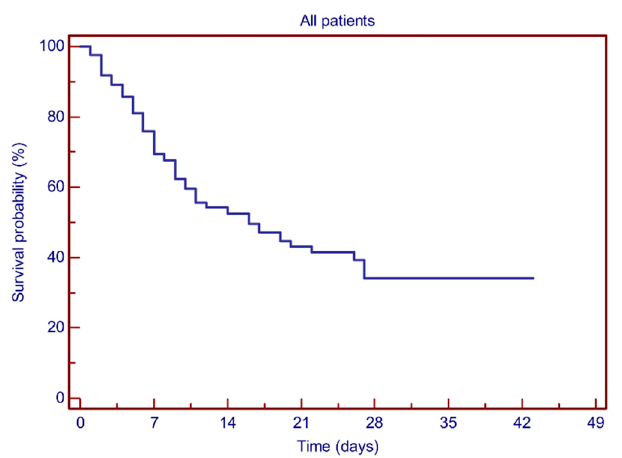
Figure 1. Kaplan–Meier plots showing the probability of survival for the whole patient popula- tion.